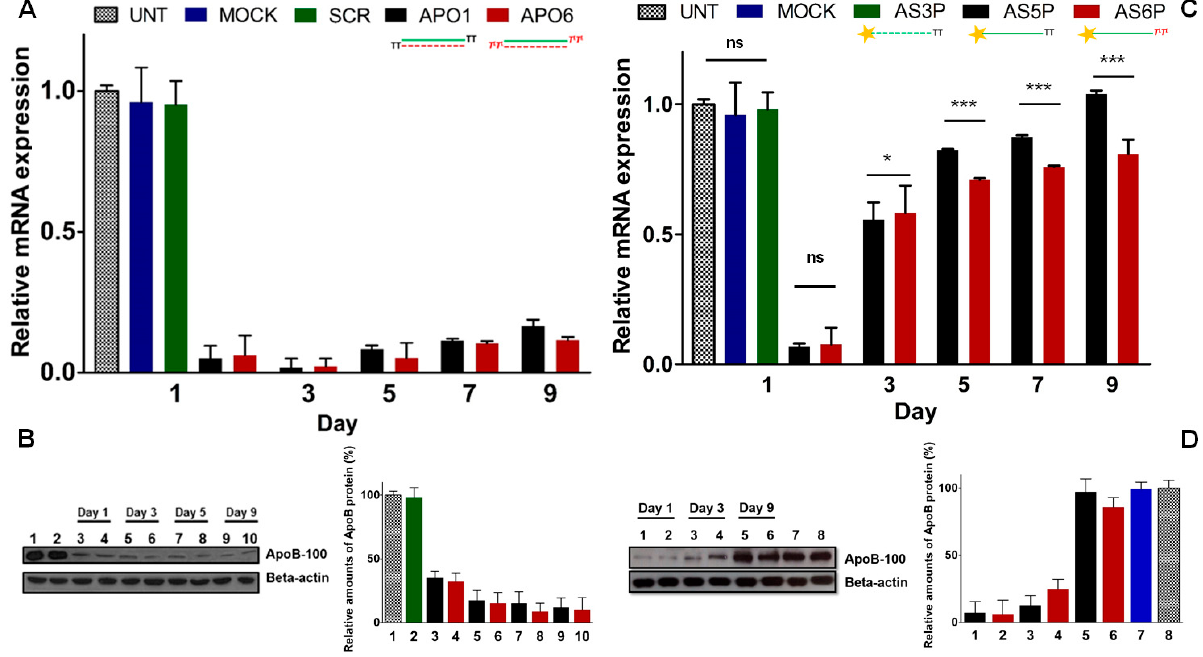
Figure 6. Knockdown of the endogenous ApoB gene in HepG2 cells. ( A ) ApoB mRNA reduction with 60 nM of unmodified APO1 and modified APO6 ds-siRNAs; ( B ) Western blot and quantification plot of ApoB protein expression after siRNAs transfection. Lane 1: Untransfected; lane 2: Scrambled; lanes 3, 5, 7, 9: APO1 siRNAs; lanes 4, 6, 8, 10: APO6 siRNAs; ( C ) APOB mRNA levels with 60 nM of 5 ′ -phosphorylated unmodified ( AS5P ) and modified ( AS6P ) single-stranded siRNAs; ( D ) Western blot and quantification plot of ApoB protein levels after treatment with ss-siRNAs (60 nM). Lanes 1, 3, 5: AS5P ss-siRNAs; lanes 2, 4, 6: AS6P ss-siRNAs; lane 7: Mock transfection; lane 8: Untransfected. n = 3 ± SD. ns = p > 0.05; * = p < 0.05; *** = p < 0.001. For quantification of ApoB protein levels, untransfected cells were set at 100%. Error bars indicate ± SD, n = 2. For experimental conditions see the Experimental